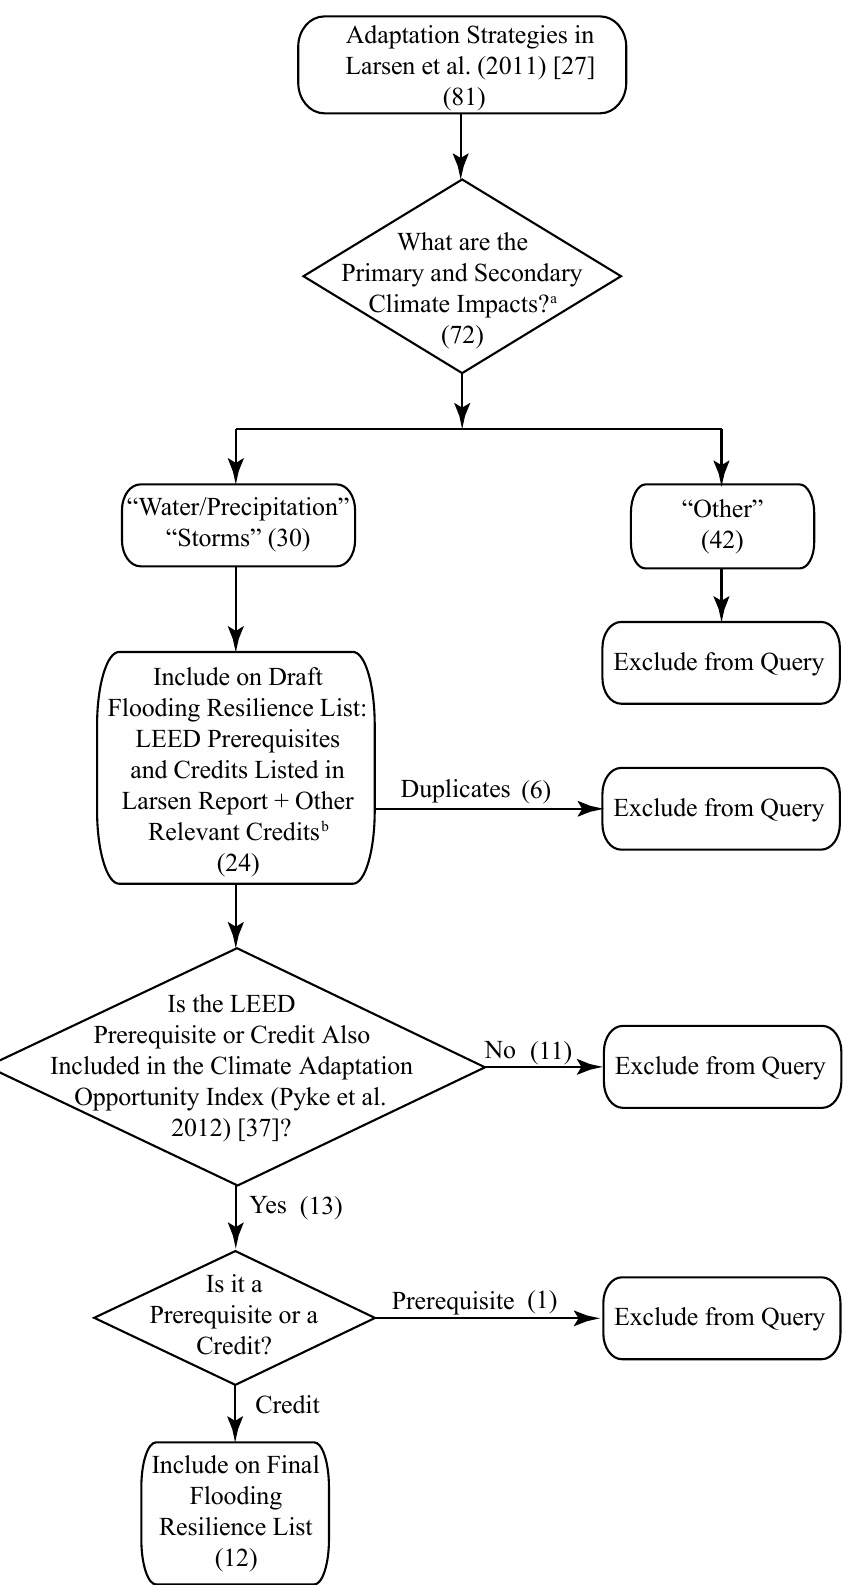
Figure 2. Flow chart of LEED credit inclusion criteria. a One or more primary or secondary impact may be designated under each adaptation strategy. b LEED prerequisites and credits may be listed under more than one adaptation strategy. Additionally, LEED for New Construction credits that are relevant to a strategy but not listed in the report were included in the assessment. PRISMA Flow Diagram adapted from Moher et al. (2009) [42].